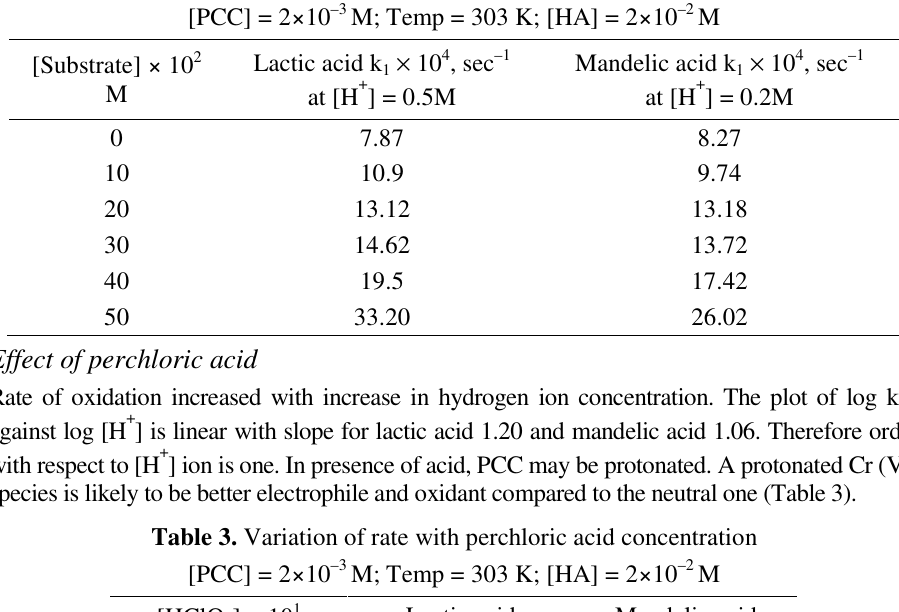
Table 2. Variation of rate with solvent composition.